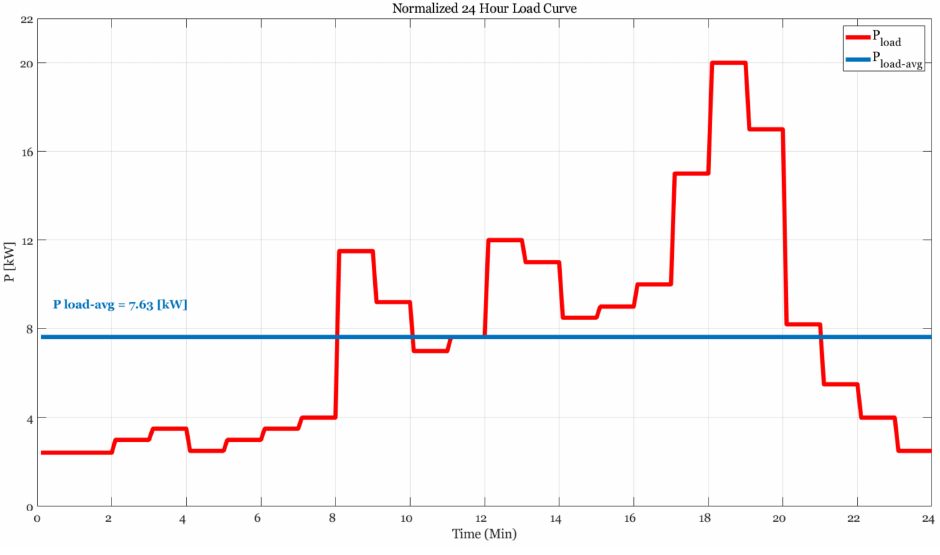
Figure 10. Normalized load power